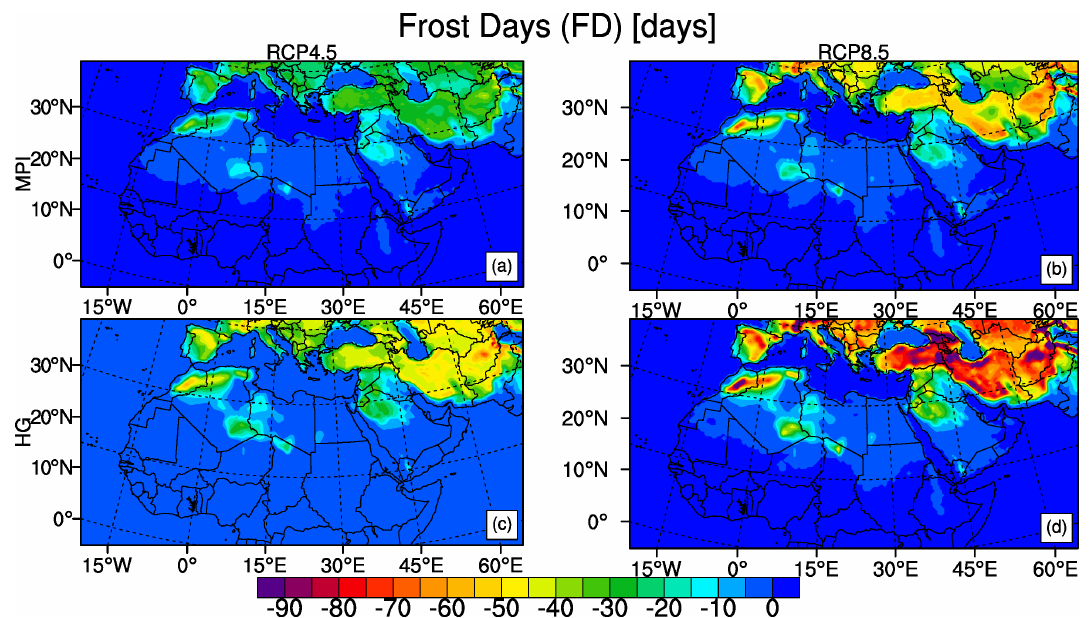
Figure 3. The temporally averaged changes in FD for the period of 2071–2100 displayed as differences (in days) with respect to the reference period 1971–2000 for the model MPI-ESM-MR with RCP4.5 ( a ) and RCP8.5 ( b ) and for the model